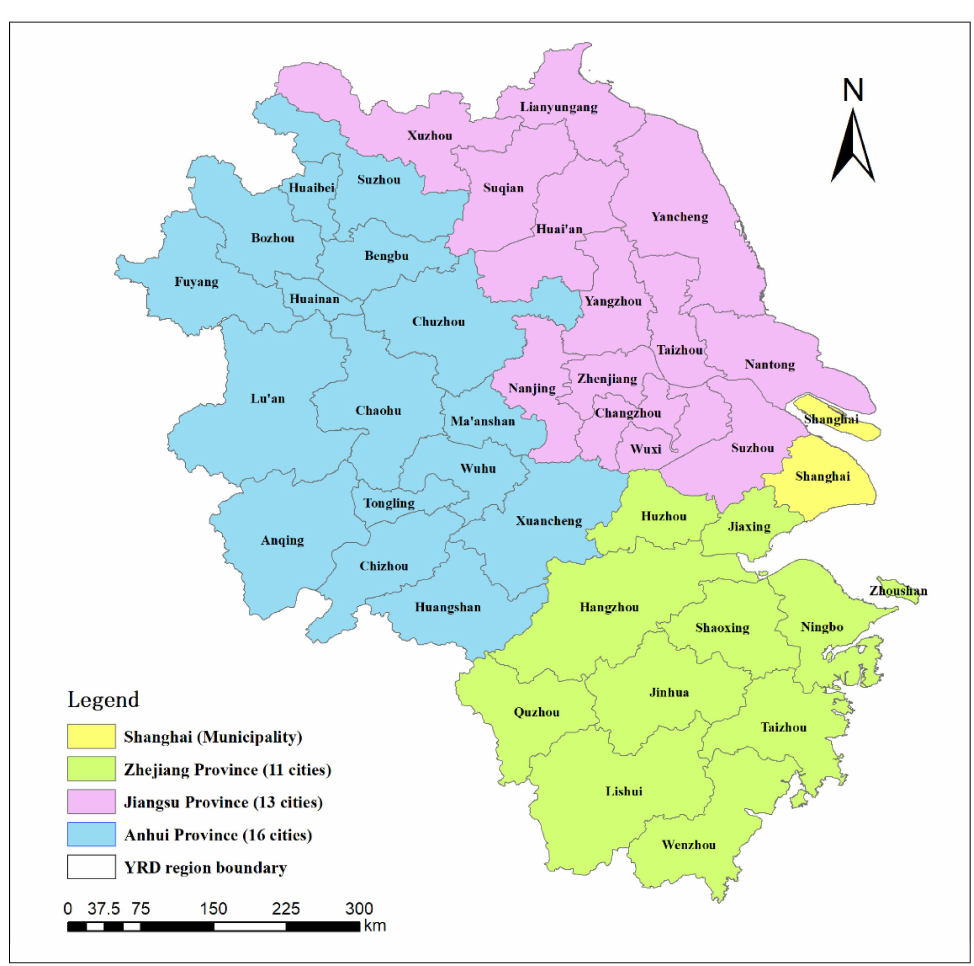
Figure 1. Location of the YRD region [4]. Reproduced from [4], with permission from Scientific Research Publishing,